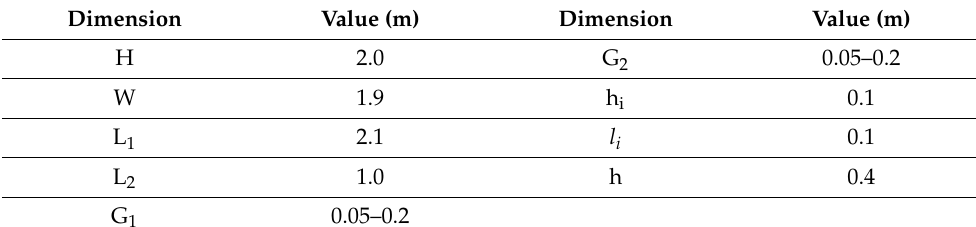
Table 1. The main dimensions of the room and the solar